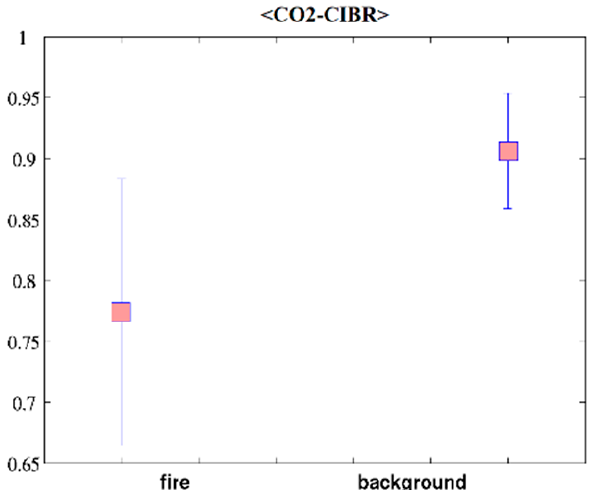
Figure 5. Separability of Ben Halls Gap National Park fire indices; mean value of the four CO 2 - CIBRs is 0.7741 ± 0.1091, and mean value of the background is 0.9664 ± 0.0477. The HFDI was retrieved by applying Equation (2) for the 24 possible band combina- tions (Figure 6).